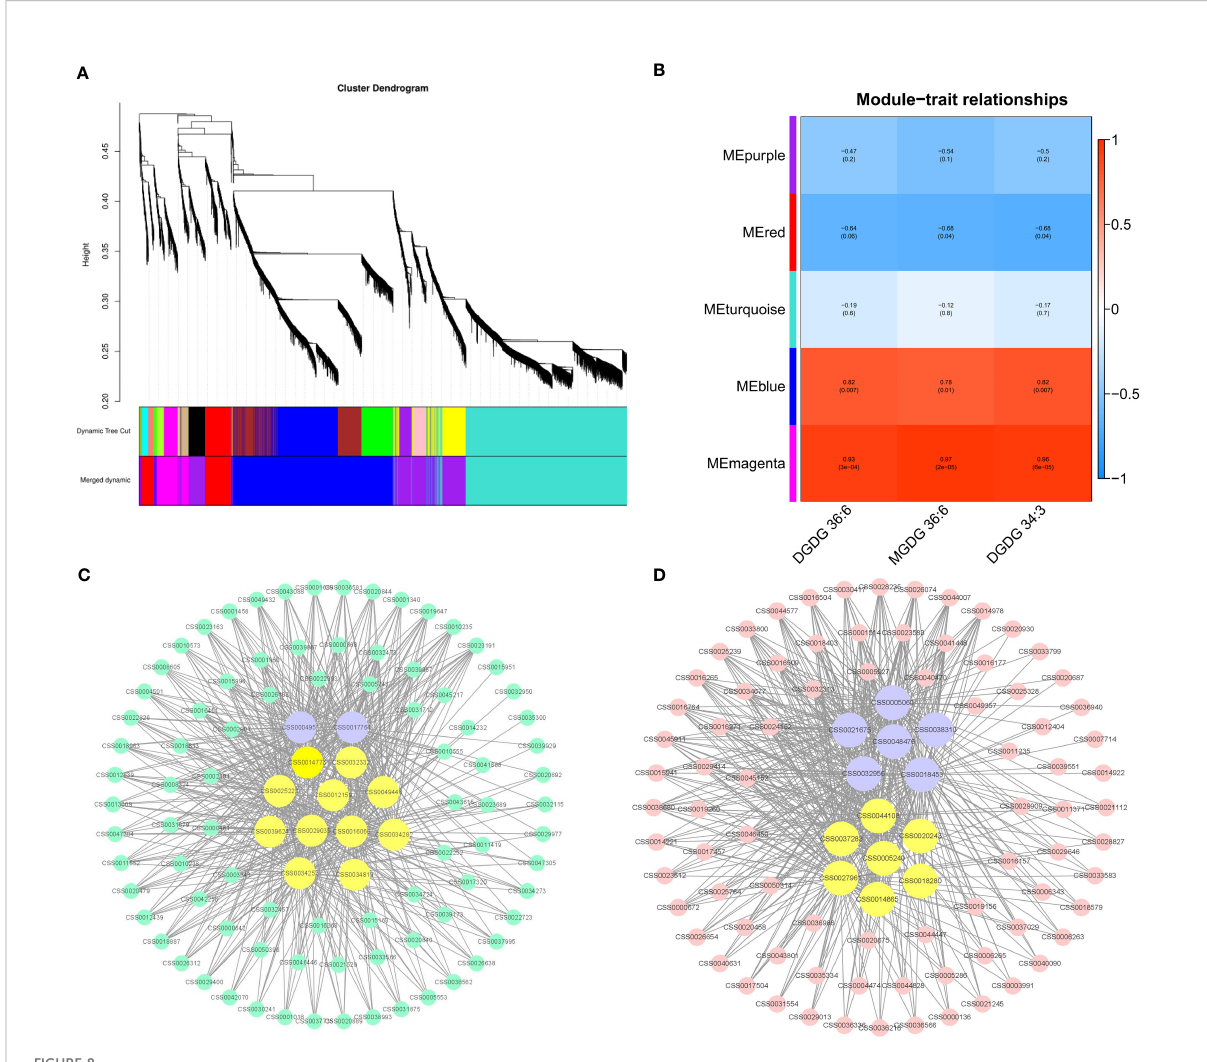
FIGURE 8 Coexpression analysis networks of lipids related to albino leaf color in BJG. (A) Cluster dendrogram and gene modules after WGCNA analysis. (B) Correlation between fi ve gene modules and the contents of three important lipid contents. (C) Coexpression network of candidate genes in the Memagenta module. (D) Coexpression network of candidate genes in the Meblue